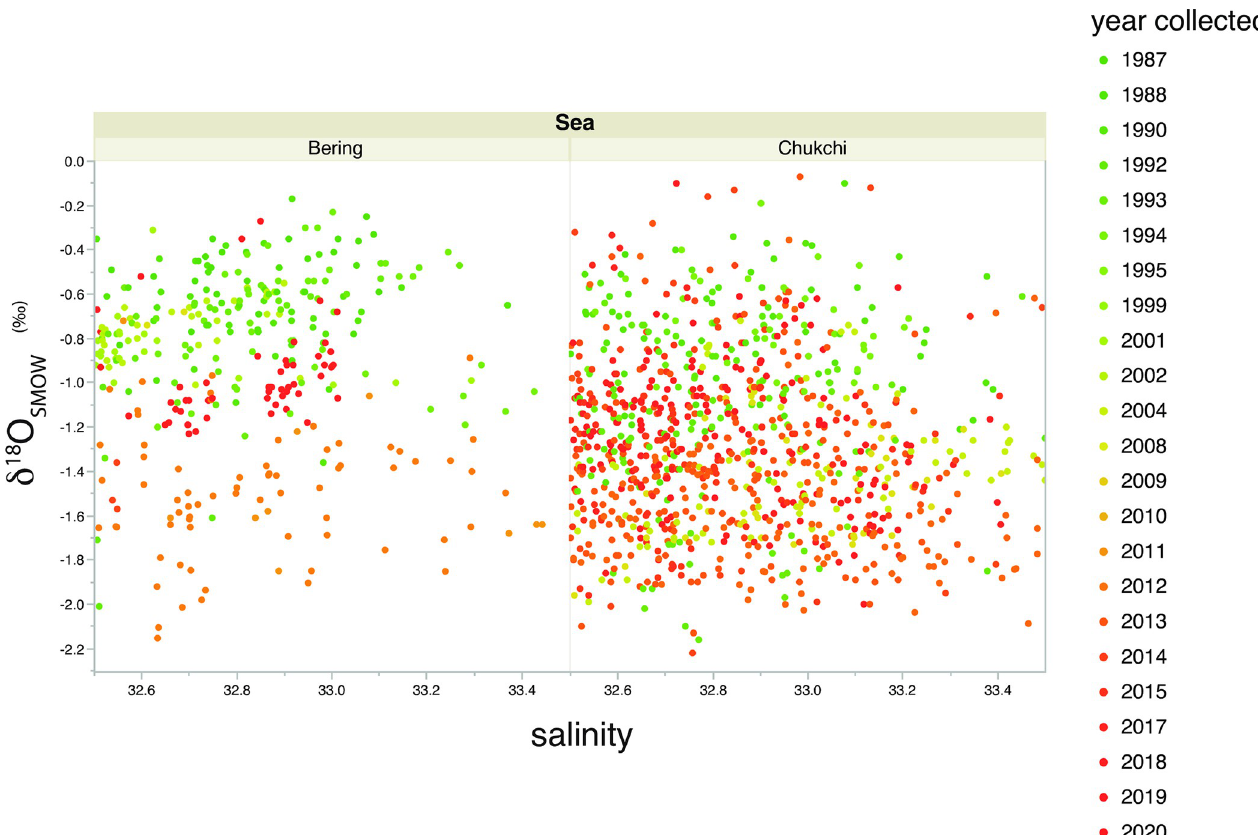
Fig 4. Distribution of δ 18 O values relative to salinity for 389 of the samples (Fig 3) collected in the Bering Sea, and 1016 samples (Fig 3) collected north of Bering Strait. Color coding of δ 18 O values by years follows that shown on Fig 3.